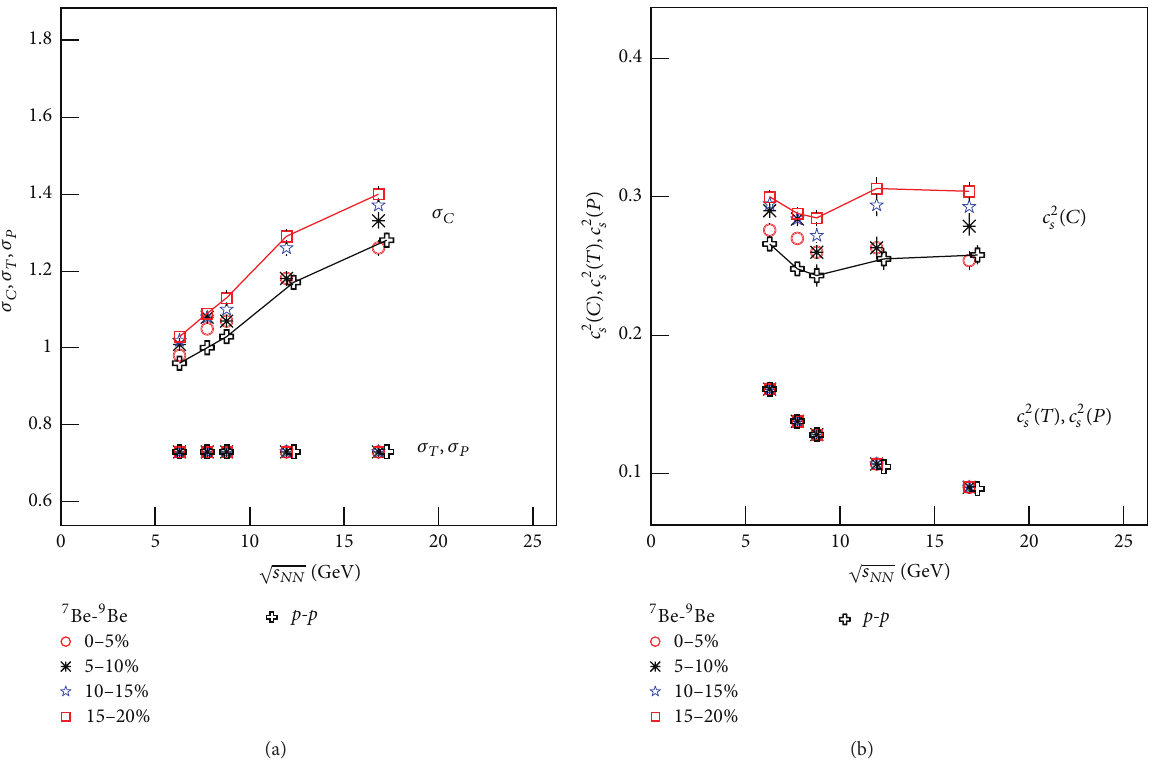
Figure 2: Dependences of (a) 𝜎 𝑋 and (b) 𝑐 2 𝑠 (𝑋) on √𝑠 𝑁𝑁 . The symbols represent the values listed in Table 1 and the line segments for two cases are given for guiding the eyes. Different symbols correspond to different types (centralities) of